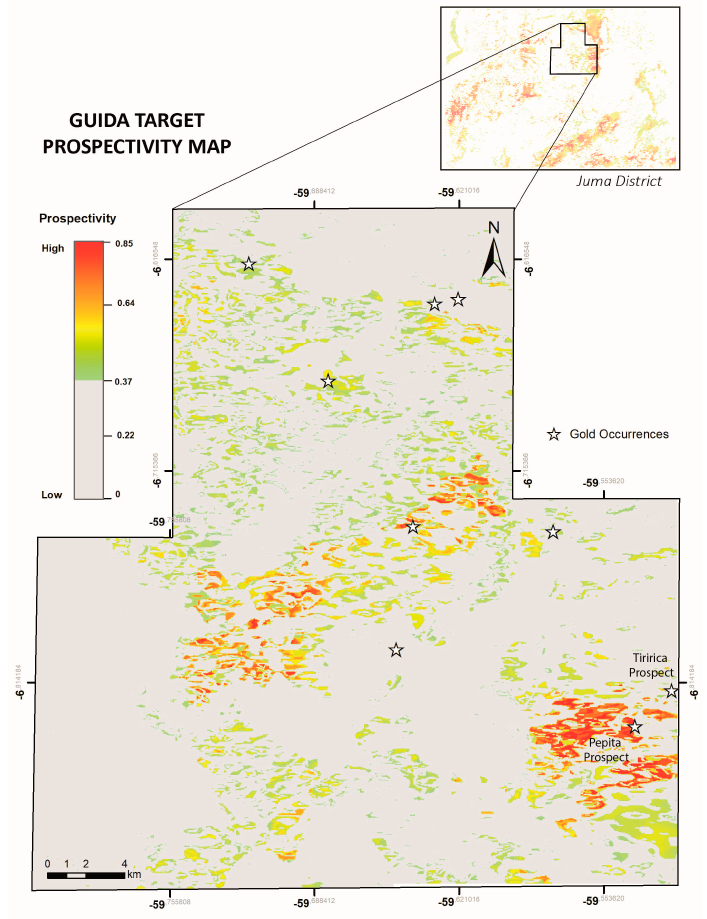
Figure 8. Guida Target mineral prospectivity map and known gold occurrences. Regions with similar potential to host magmatic–hydrothermal gold are delimited by the prospectivity scores (0–0.85). The higher values correspond to the most favorable areas (warm colors). The areas corresponding to medium and low prospectivity scores (0–0.37) are shown in